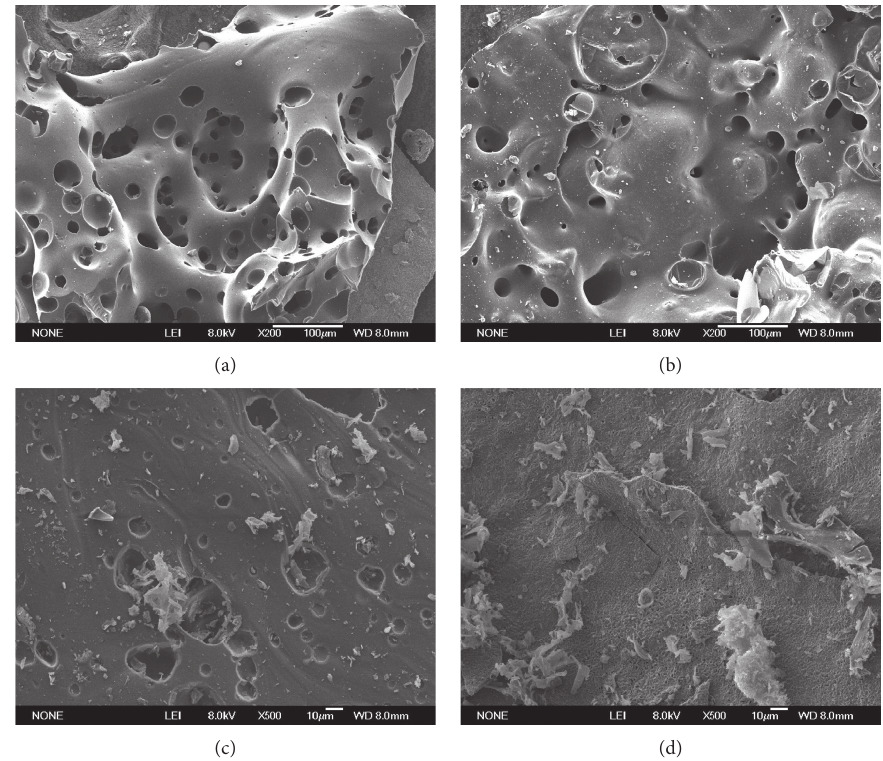
Figure 8: SEM images of char residues of (a) TPU, (b) TPU1, (c) TPU2, and (d) TPU3 after CCT.